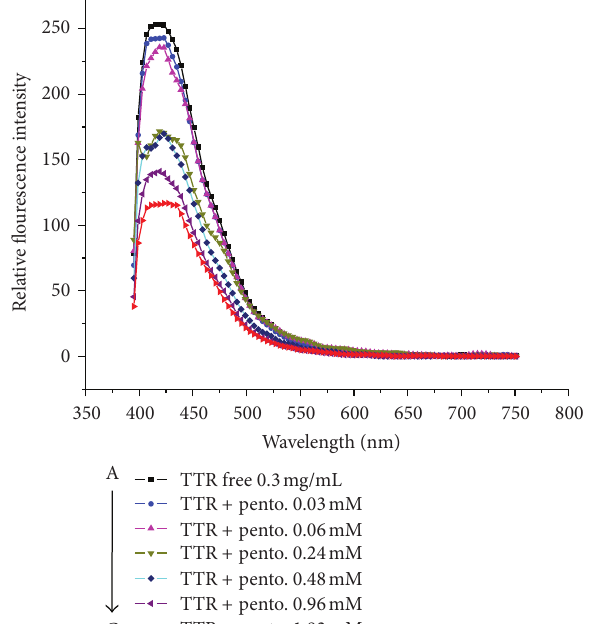
F 2: Fluorescence emission spectra of TTR pentobarbital complexes at different pentobarbital concentrations.